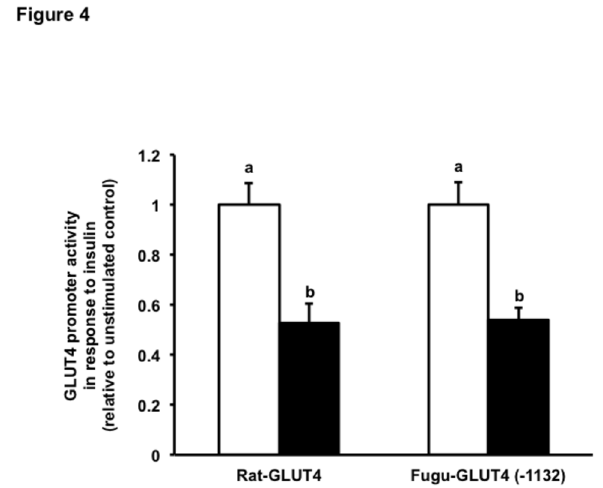
Figure 4. Activity of the rat and Fugu GLUT4 promoters in response to insulin. Rat and Fugu GLUT4 promoters were transiently transfected into L6 muscle cells and these were incubated in the absence (unstimulated control; white bars) or presence of human recombinant insulin (100 nM; black bars) for 18 hr. Data are normalized to the relative expression of Renilla luciferase activity, setting the activity of the unstimulated promoter to 1. Data on GLUT4 promoter activity in response to insulin are shown relative to that of the unstimulated control and expressed as mean ± S.E. of three independent experiments. Different letters indicate statistically significant differences ( p